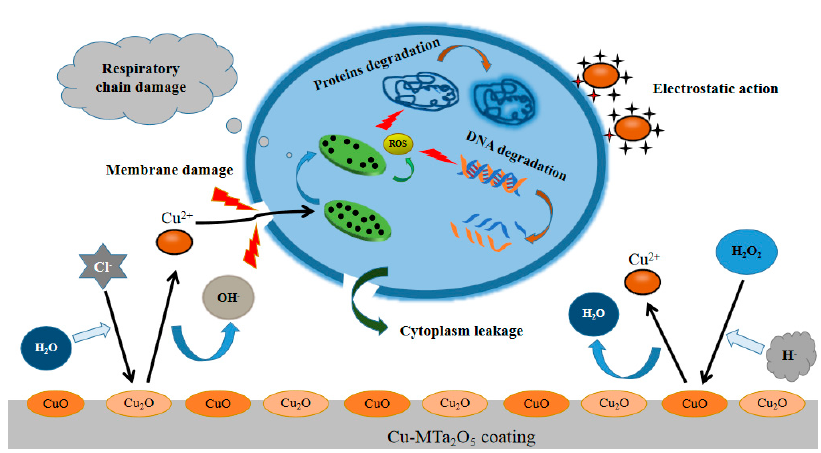
Figure 12. Schematic diagram of possible sterilization mechanism of Cu ions released by Cu-MTa 2 O 5 coating.